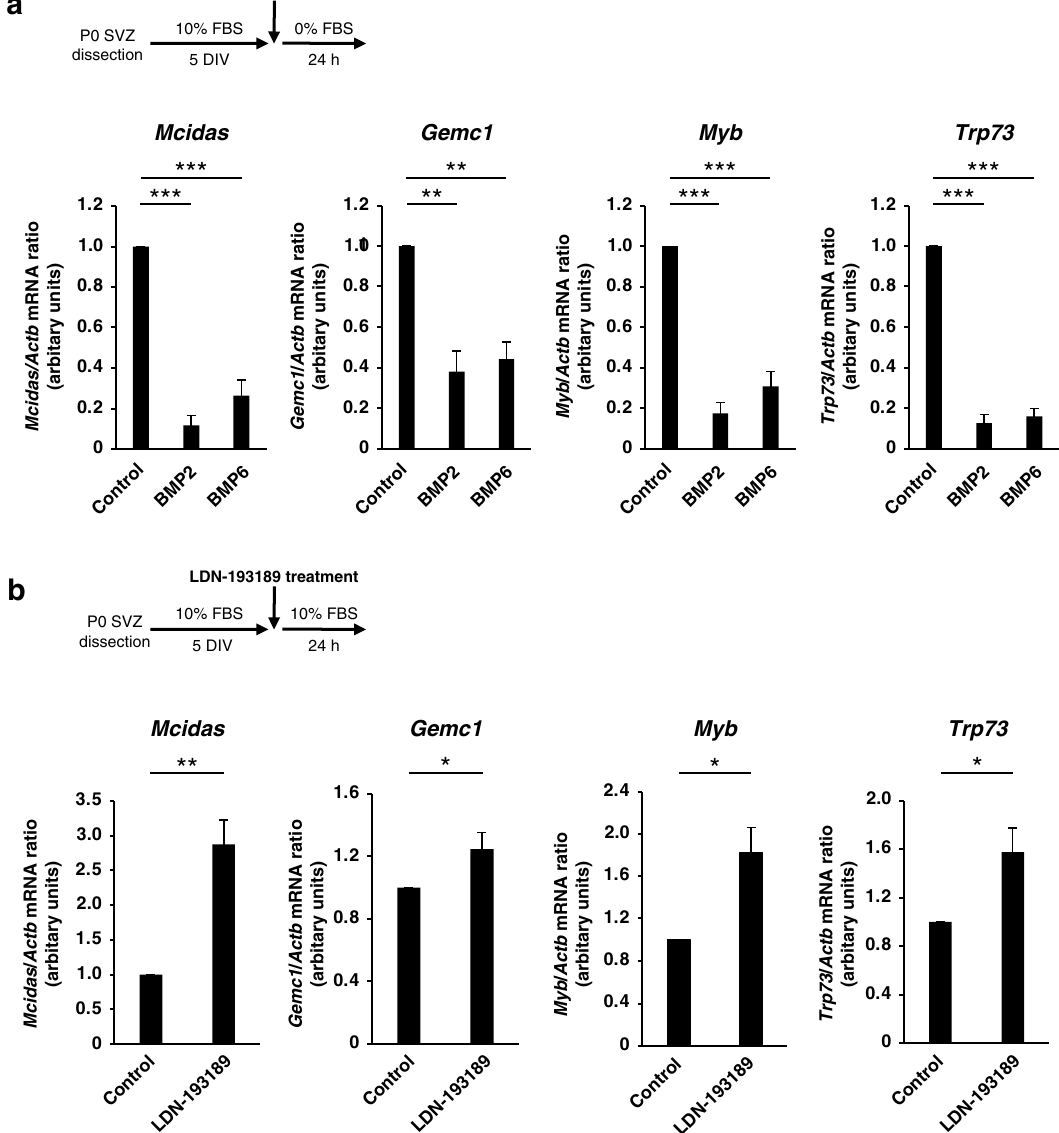
Figure 5. BMP signaling suppresses the expression of initial key regulators of ependymal cell differentiation. ( a ) P0 NPC cultures maintained for 5 days in the presence of 10% FBS and then for 24 h in serum-free medium containing BMP2 (50 ng/ml) or BMP6 (50 ng/ml) were subjected to quantitative RT-PCR analysis for determination of the amounts of Mcidas , Gemc1 , Myb , and Trp73 mRNAs. Data are means ± SEM (n = 8 independent experiments). ** p < 0.01, *** p < 0.001 (Tukey’s test). ( b ) P0 NPC cultures maintained for 5 days in the presence of 10% FBS and then for 24 h in the additional absence or presence of LDN-193189 (0.1 μM) were analyzed as in ( a ). Data are means ± SEM (n = 7, 10, 7, or 6 independent experiments, respectively). * p < 0.05; ** p < 0.01 (two-tailed Student’s paired t